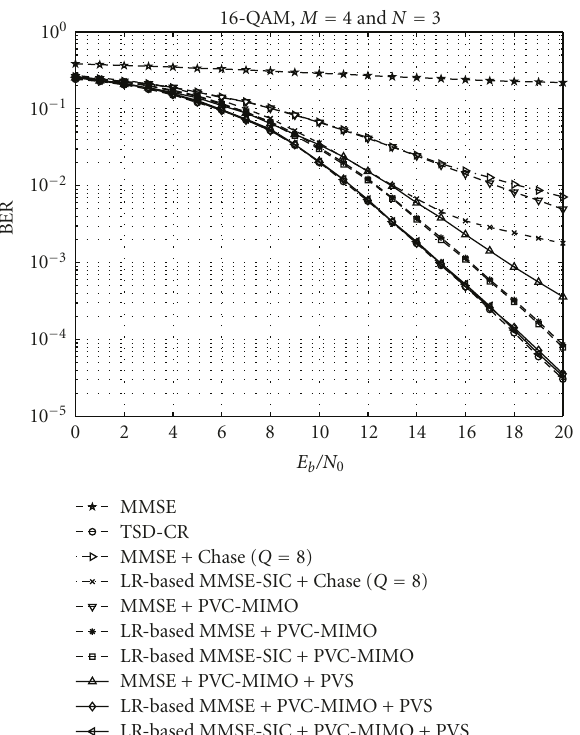
Figure 4: BER versus E b /N 0 of di ff erent detectors represented in Section 5.1 for 16-QAM, M = 4, N = 3.